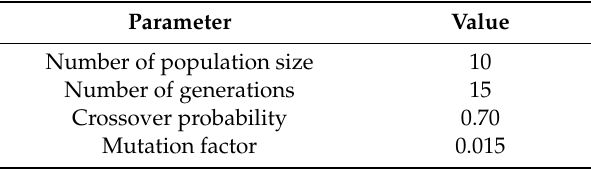
Table 2. The parameters of Genetic Algorithm.